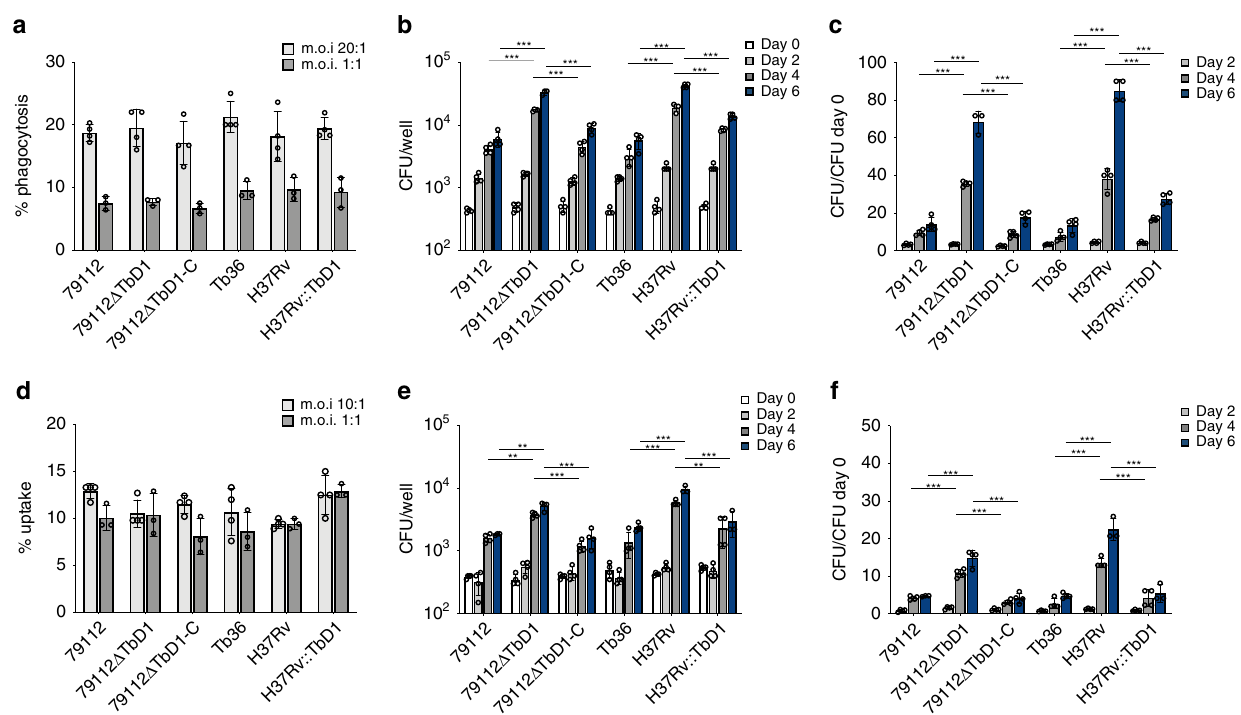
Fig. 4 Intracellular growth pro fi les of TbD1 WT and mutant strains in THP-1 and A549 human cell lines. a – c Comparative analysis of the percentage of phagocytosis ( a ) and growth ( b , c ) of TbD1-intact and Δ TbD1 WT and mutant strains in human THP-1 cells. d – f Comparative analysis of the percentage of uptake ( d ) and growth ( e – f ) of TbD1-intact and Δ TbD1 WT and mutant strains in human A549 cells. For determination of the percentage of uptake, THP-1 cells were infected at m.o.i 20:1 and 1:1 (cells: bacteria), while A549 cells were infected at m.o.i 10:1 and 1:1 (cells: bacteria). The comparison of growth kinetics of different TbD1-intact and Δ TbD1 WT and complemented strains was undertaken at m.o.i 20:1 (cells:bacteria) for THP-1, and 10:1 (cells:bacteria) for A549. These m.o.i ensured the integrity of the infected cell monolayer over a 6-day period. In both these ex vivo models, the numbers of intracellular bacteria (CFU) were determined immediately after phagocytosis and at different time points (as indicated in panels b , e ). CFU ratio values (CFU at different time points/CFU at day 0) are reported in c , f . The statistical signi fi cance of differences in CFU and CFU ratio values among the strains were determined by one-way Anova with Bonferroni post hoc test. Only the statistical signi fi cance of differences between the 79112 Δ TbD1 mutant and its corresponding control strains (79112 and 79112 Δ TbD1-C) or H37Rv and its derivative H37Rv::TbD1 and related control Tb36, at days 4 and 6 post infection are depicted in the fi gure (** P < 0.01; *** P < 0.001). The fi gure shows the single data points, mean and standard deviations of uptake percentage, CFU numbers and